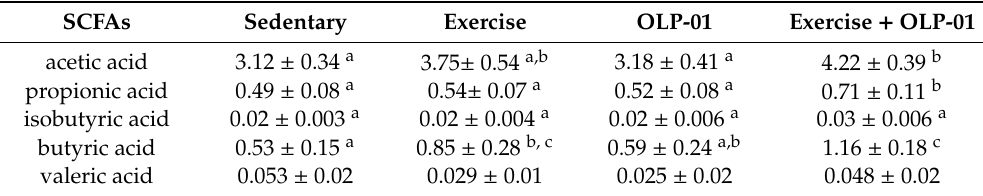
Table 5. The e ff ects of exercise and probiotics on fecal short-chain fatty acid content.